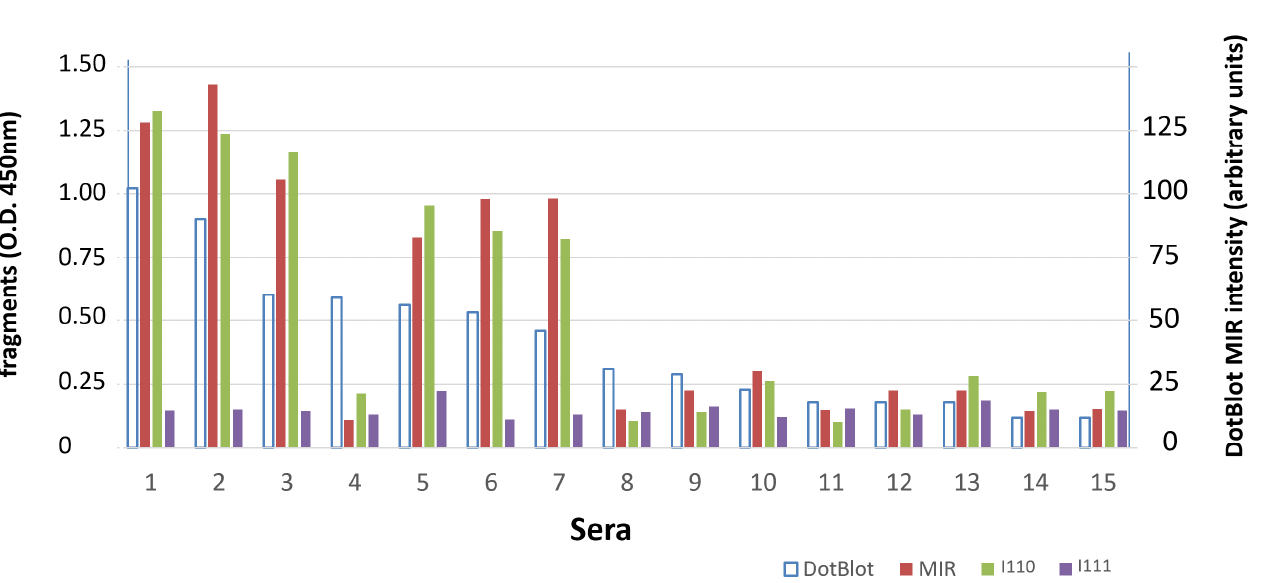
Figure 5. Binding to titin fragments of sera from patients suspected for paraneoplastic syndromes. Patients’ sera were initially screened for antibodies to 13 paraneoplastic antigens, including titin MIR, by dot blot. All sera which were found positive for titin MIR by dot blot (1st column for each serum shows the intensity of the dot in arbitrary units; right Y -axis) were further tested by ELISA for binding to the 3 MIR fragments: whole MIR, I110 and I111. The 3 solid bars for each patient represent ELISA values for the immobilized fragments: whole MIR, I110 and I111 (left Y -axis). It is shown that a) there is a good correlation between dot blot MIR intensity and ELISA MIR values, with only one exception (patient 4); b) as with the MG sera, binding to the I110 is very similar with that to the MIR, whereas practically no serum was bound to I111.